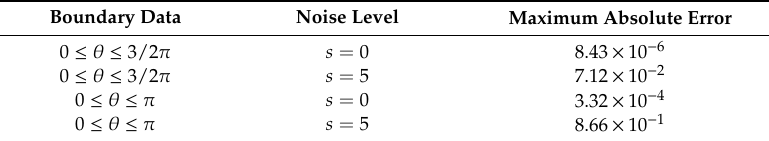
Figure 14. Boundary collocation points. Table 1. The MAE by assigning di ff erent levels of noise for example